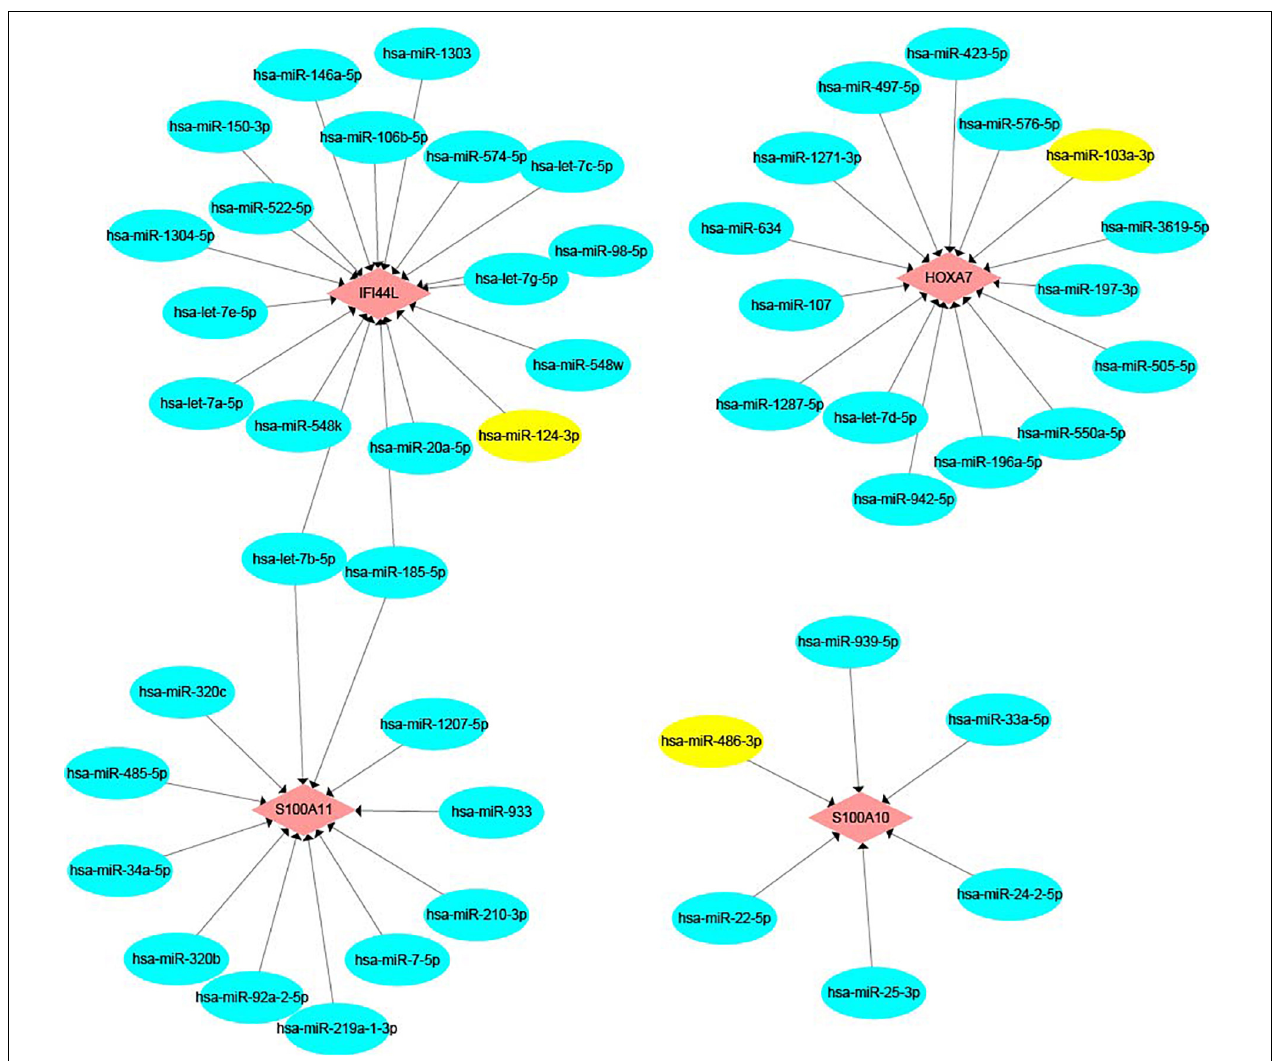
FIGURE 10 | The mRNA-miRNA network. Pink color represents target genes and blue color represents miRNA. Yellow color shows hsa-miR-124-3p, hsa-miR-103a-3p, and